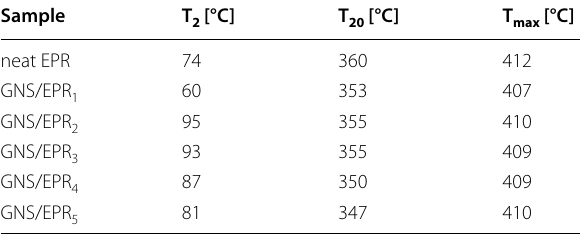
Table 2 Thermoanalytical data of neat EPR and its GNS/EPR graphene-containing nanocomposites under nitrogen flow